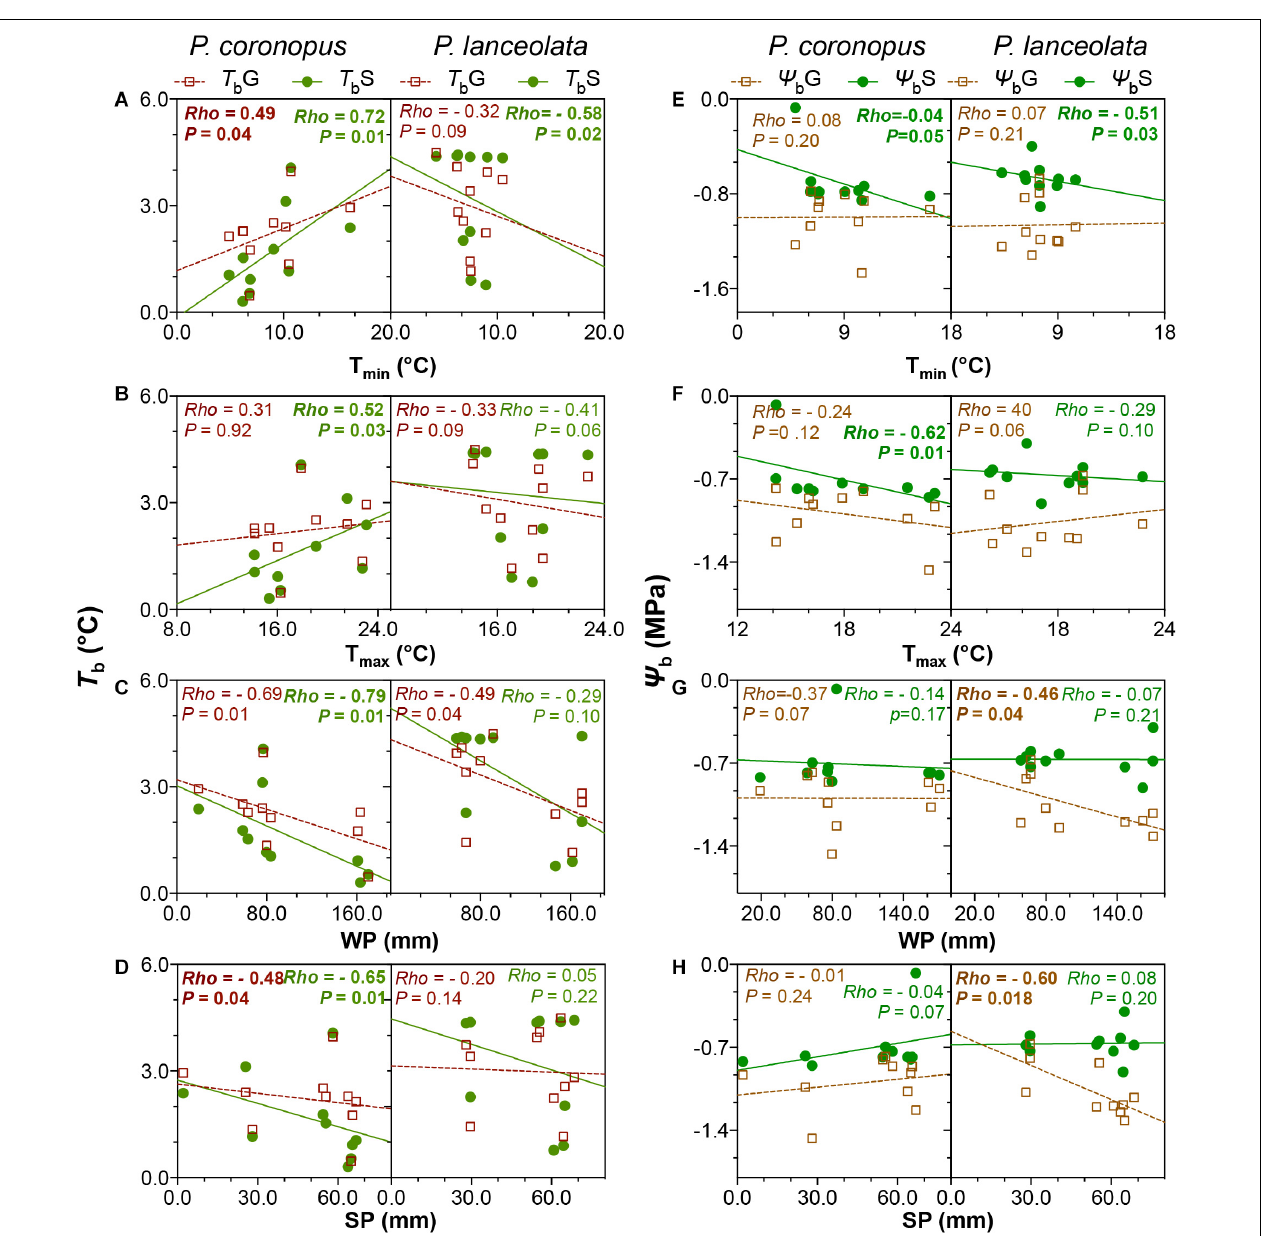
FIGURE 5 | Linear regressions for P. coronopus and P. lanceolata base temperatures (A–D) and base water potentials (E–H) against the climate traits: minimum (T min ; A,E ) and maximum (T max ; B,F ) temperatures; winter (WP; C,G ) and summer (SP; D,H ) precipitation. For each species, the means of three replicate values of 10 accessions were plotted. In each panel, T b G is displayed by brown open squares and brown dotted regression lines, and T b S by green closed symbols and green solid regression lines. Osmoticum traits show similar representation. Each panel shows the Spearman’s correlation ( rho ) coefficients and p